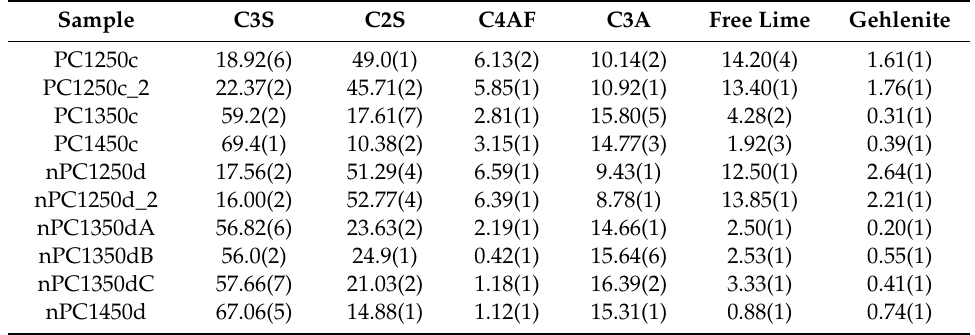
Table 3. Results of Rietveld refinement of XRPD data [46]. Data are normalized to the crystalline portion of the analyzed samples, without taking into account the amorphous